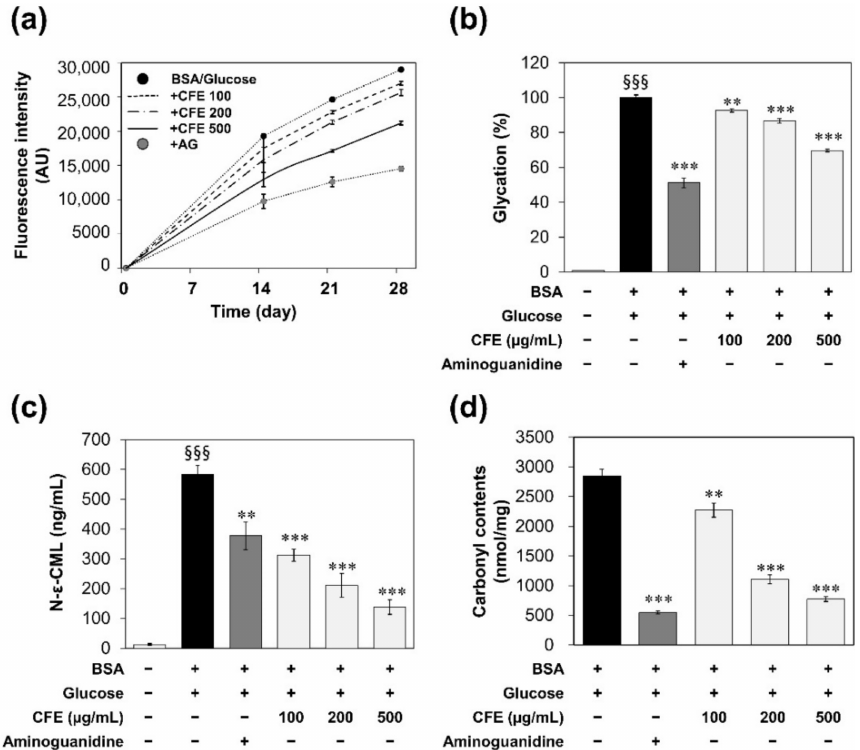
Figure 1. The effects of CFE on BSA/glucose glycation system. ( a ) Fluorescence intensity of AGEs in glucose-modified BSA for 28 days of incubation. These data were represented in the arbitrary unit (AU). ( b ) Percent glycation of glucose-modified BSA at 21 days after incubation. These data were calculated as a percentage (%) of the fluorescence intensity of the sample compared to the control (BSA+/glucose+). ( c ) CML concentration (ng/mL) in glucose-modified BSA at 21 days after incubation. ( d ) Carbonylated protein contents in glucose-modified BSA at 21 days after incubation. These data were represented as the amount of carbonyl per protein in the sample (nmol/mg). Statistical significances were represented as follows: **, p < 0.01; ***, p < 0.001 compared to the